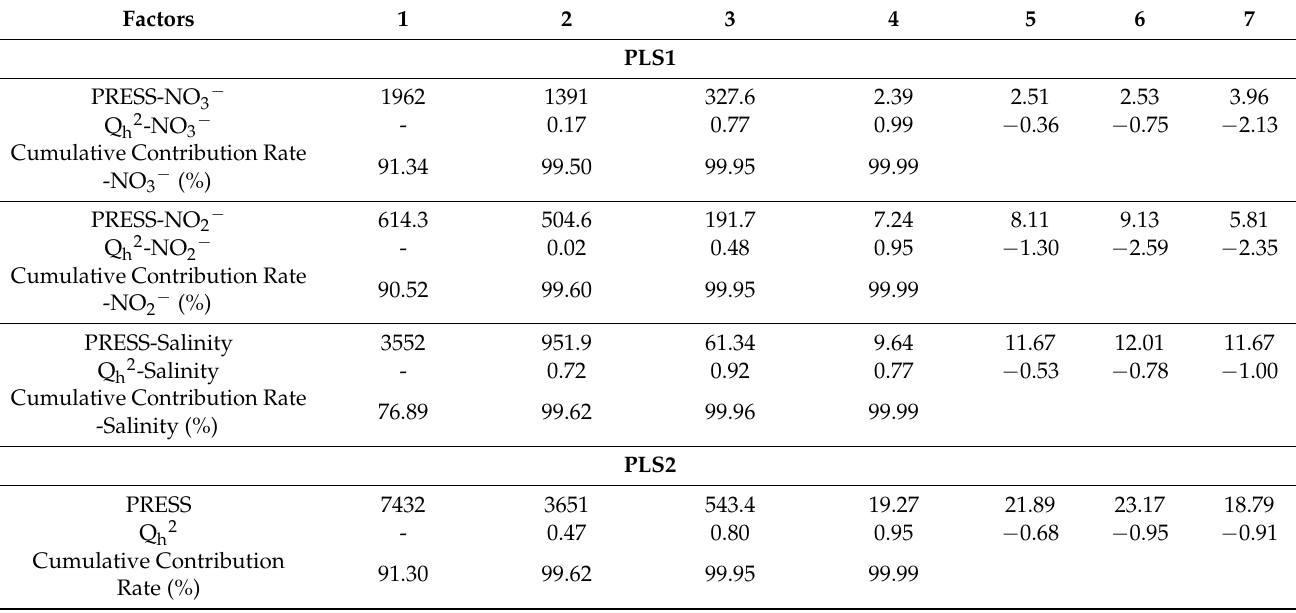
Table 2. The Q h2 values of cross-validation with the number of